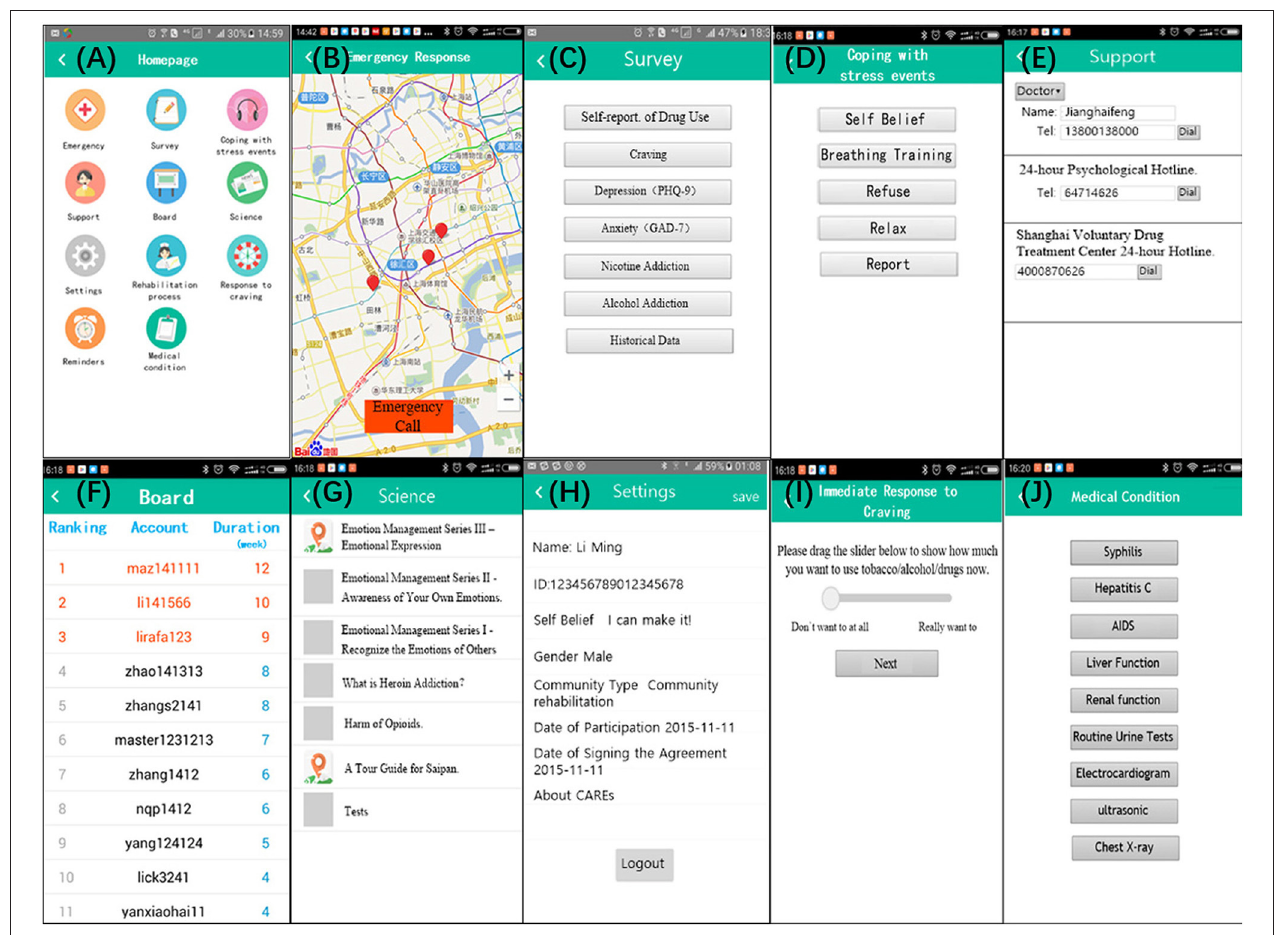
FIGURE 2 | “Screenshots” taken on a phone device illustrating the user interface: no Regular reminders and Rehabilitation Process Management above for: (1) Regular reminders will only be used when users receive messages from service providers or server; (2) Rehabilitation process involves in some privacy of the patients. For better understanding, we translated some Chinese on the pages into English. CAREs actually is presented in